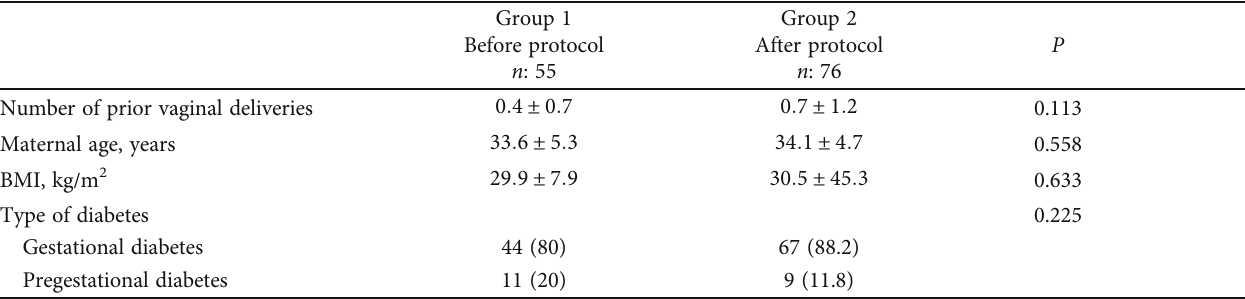
Table 2: Maternal antenatal characteristics of women with diabetes in pregnancy who delivered before (group 1) and after (group 2) the introduction of a standardized multidisciplinary management protocol.